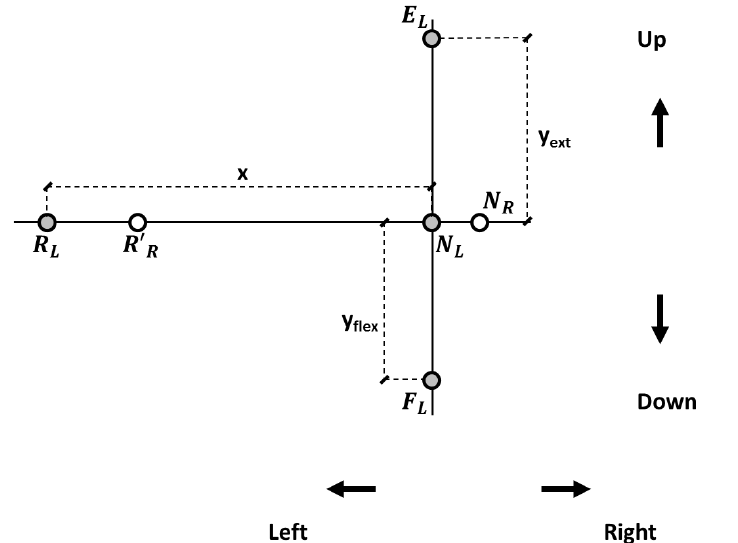
Figure 2. Target reference points in the panel reference frame. N R and N L : positions of the right and left lasers’ projections, respectively, with the head in the neutral position (NHP). Target reference points for the left laser pointer at 25 ◦ for neck extension (E L ) and flexion (F L ) and at 30 ◦ (R L ) for left rotation. R’ R represents the right laser pointer when rotating to the left side. An analogous procedure was followed for right rotation (not shown).